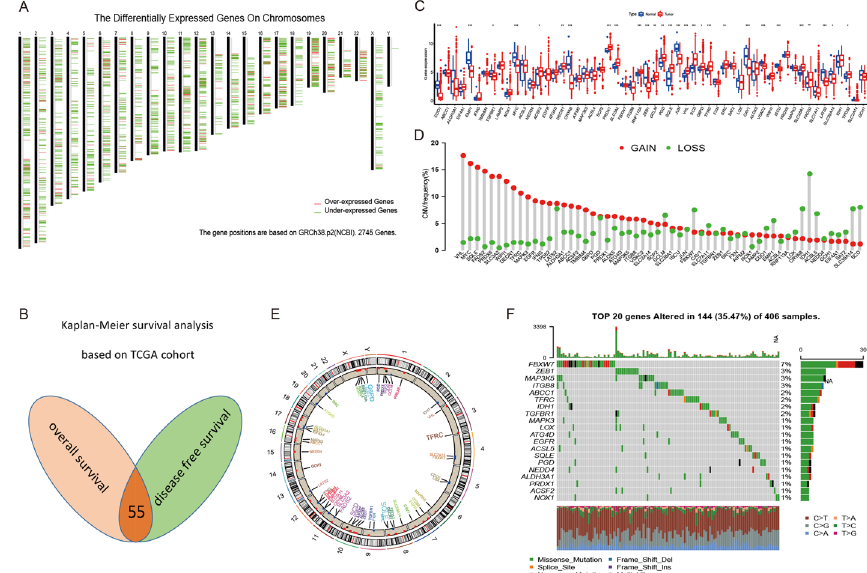
Fig. 2 Identification of potential tumor antigens and landscape of genetic and expression variation of ferroptosis regulators in bladder cancer. A Potential tumor‑associated antigens of BCa. B Overlap genes of univariate Cox regression analysis based on overall survival and disease‑free survival. C The expression of ferroptosis regulators between normal tissues and BCa tissues. (*p < 0.05; **p < 0.01; ***p < 0.001). D The CNV variation frequency of ferroptosis regulators in TCGA‑BLCA cohort. E The location of CNV alteration. F The mutation frequency of top20 ferroptosis